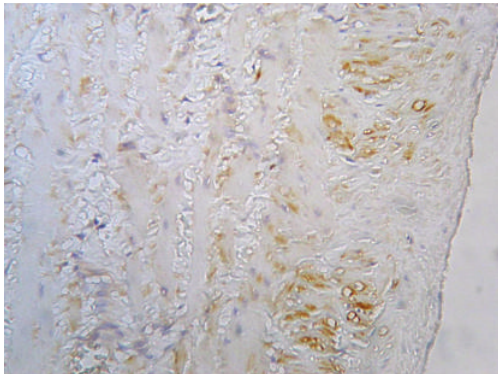
Figure 9: Enhanced nNOS positivity in the tunica intima (com- pared with tunica media) of varicose vein of 30-yrear-old man (V54), magnification 400x, DAB.